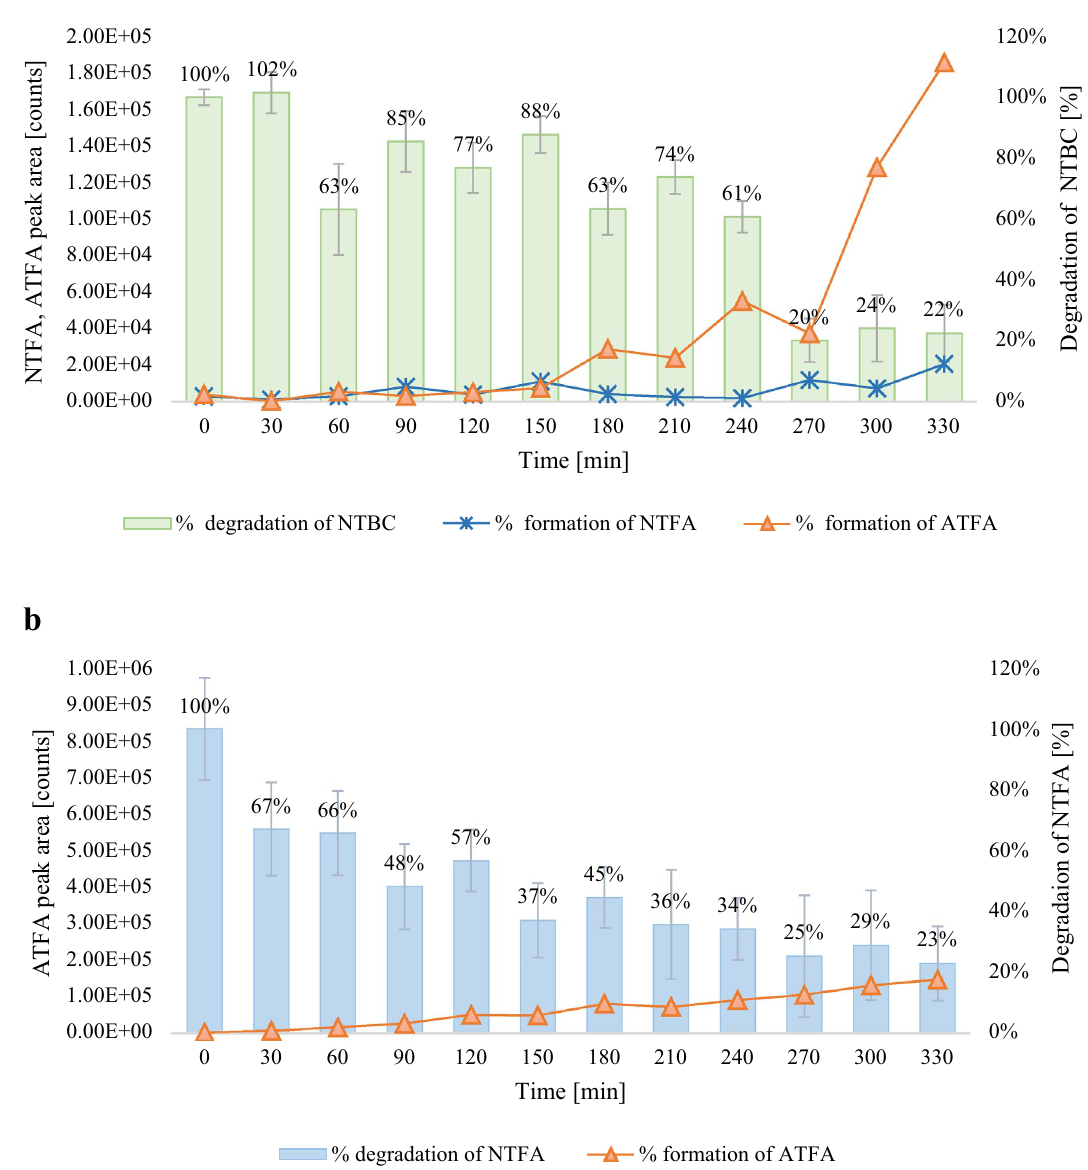
Figure 3. Degradation rate of ( a ) NTBC and ( b ) NTFA during incubation. Data are expressed as mean (n = 3); error bars represent